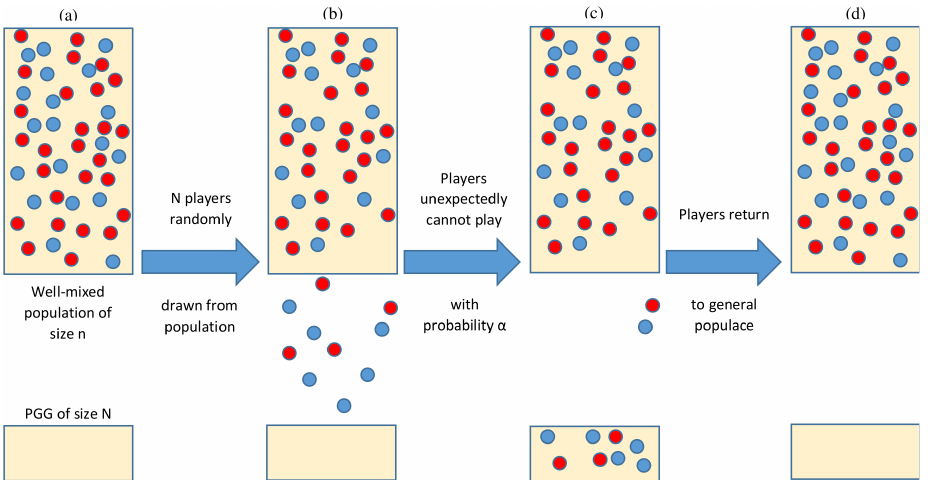
Figure 1. Model schematic of stochastic opting-out. Cooperators (blue) and defectors (red) are represented by dots. A fixed number of agents are randomly drawn from the population to participate in a PGG, represented by the small tan rectangular area. While most selected agents are able to make it to the game, some are not. Selected agents then return to the general populace, where no game is occurring. The fitness of agents is determined by the average payoffs they obtain from PGG interactions (cooperators vs. defectors) as well as from non-participation. Natural selection drives the co-evolutionary dynamics of opting-out behavior (the probability of non-participation, α ), and cooperation (the probability to cooperate in the PGG, β